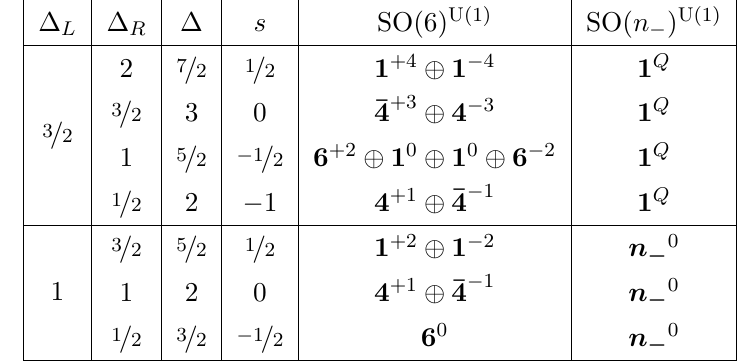
Table 8. Mass spectrum for the SU(4 group SL(2) Sp(4 ; R ). (cid:2)